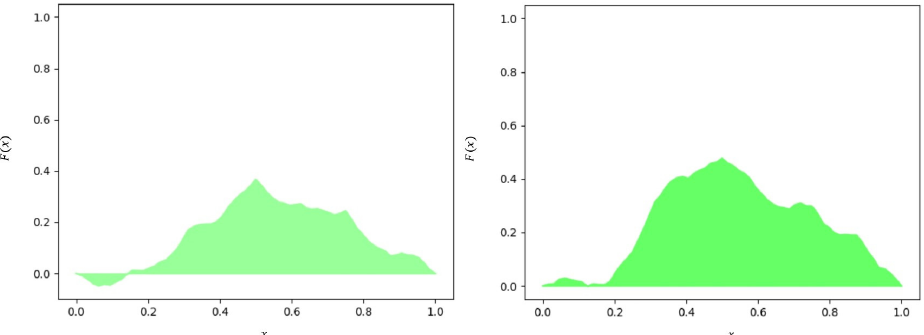
Figure 10. Colored landscapes generated from